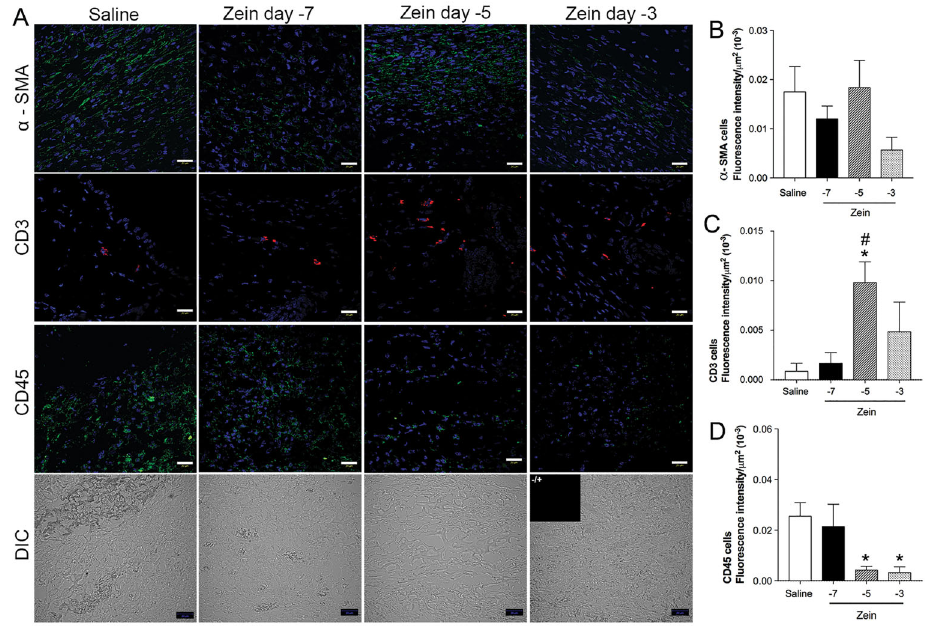
Figure 5. Subcutaneous injection of zein before skin injury reduced leukocyte number and increased T cells in the wound bed. A , Representative images of skin after immunostaining with anti- a -SMA (myo fi broblasts), anti-CD3 (lymphocytes), or anti-CD45 (leukocytes) and nuclear counterstaining with 4 ’ 6-diamidino-2-phenylindol (blue), 7 days after skin injury. The bottom row shows typical sections of each group imaged using differential interference contrast (DIC) and an insert with a picture of control staining lacking the primary antibody. Scale bars: 20 m m. Fluorescence intensity in sections immunostained with anti- a -SMA ( B ), anti-CD3 ( C ), or anti-CD45 ( D ). Control mice and mice injected with zein at 7, 5, or 3 days before injury. Data are reported as means ± SE (n=6). *P p 0.05 compared with the saline group, # P p 0.05 compared with the zein – 7 group